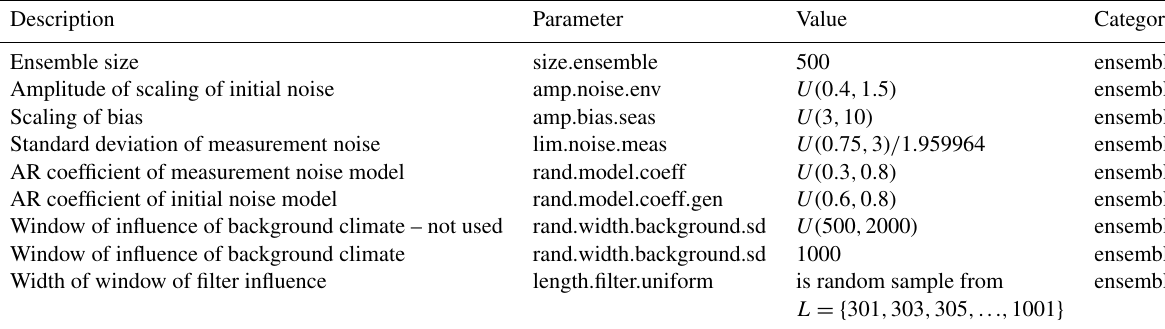
Table A4. Continuation of list of parameters